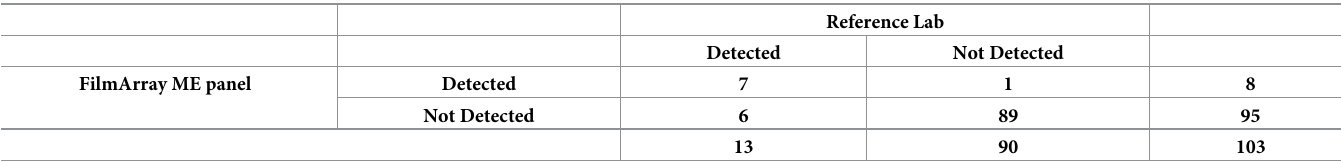
Table 3. Specimens that underwent duplicate testing for viral